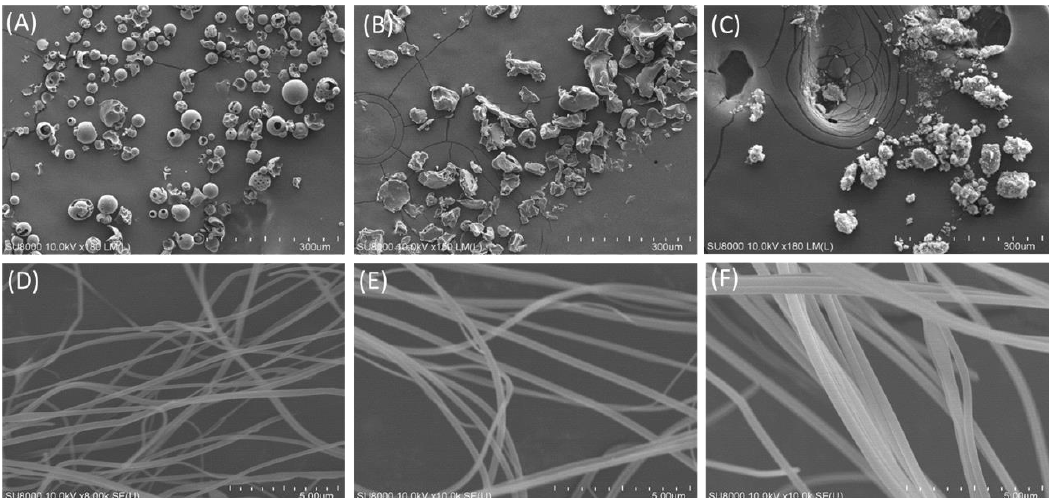
Figure 2. Surface morphology of excipients, oleanolic acid (OA), and its nanofibers under scanning electron microscope (SEM). ( A ) HBPCD, ( B ) PVPK90, ( C ) OA, and the different ratios of oleanolic acid nanofibers (OA:PVP:HPBCD, w / w / w )